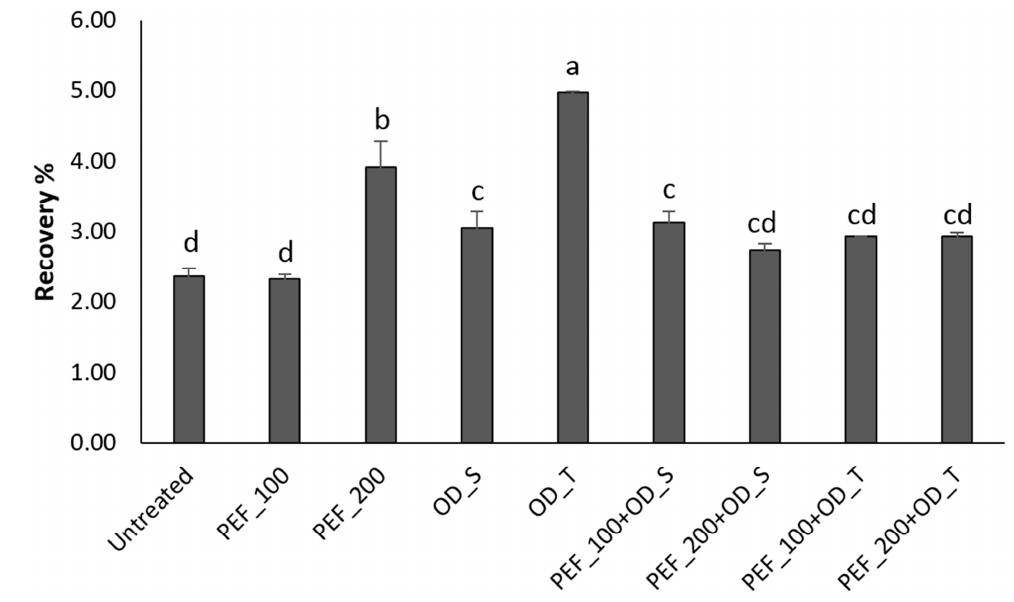
Figure 2. Relative recovery of cyanidin-3- O -glucoside after in vitro digestion of untreated and treated strawberry samples. Different letters indicate significant differences ( p < 0.05) between treatments, based on Tukey’s tests ( n = 3). PEF refers to pulsed electric field, at 100 or 200 V · cm − 1 , and OD refers to osmotic dehydration with sucrose (S) or trehalose (T).